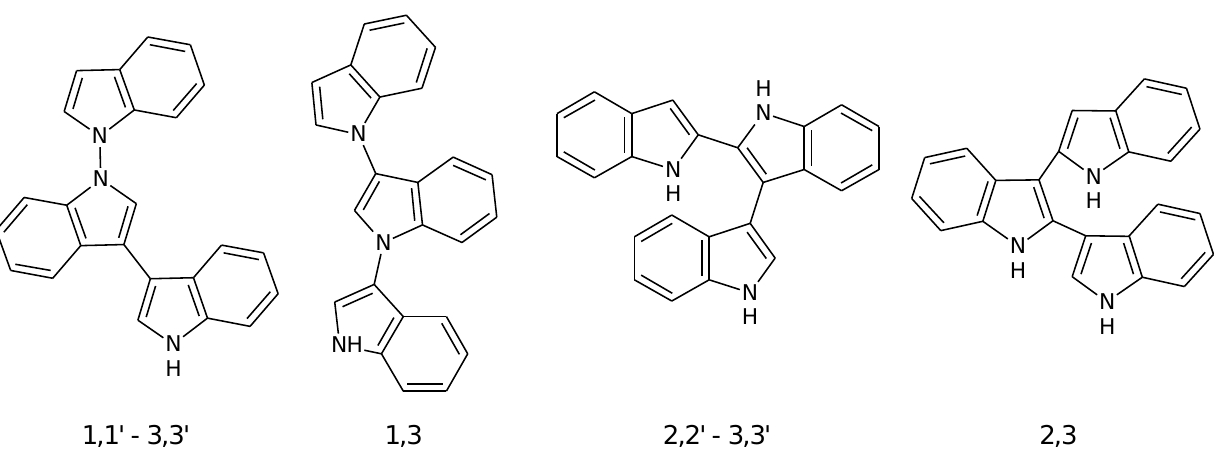
Figure 1. Possible coupling sites for the polymerization of